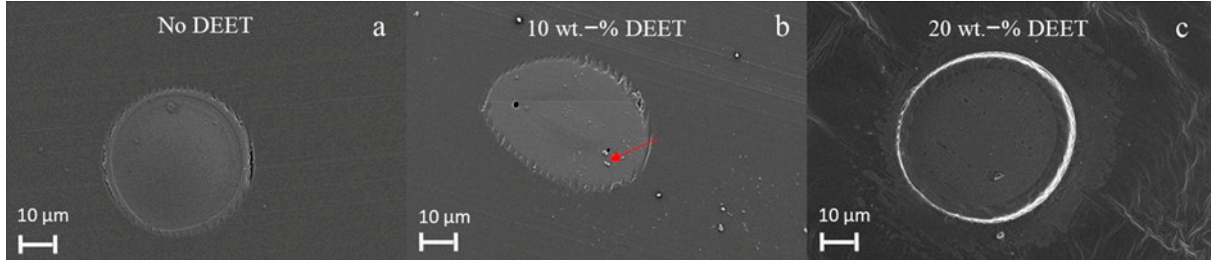
Figure 9. SEM images of PDLLA monofilaments with no DEET ( a ), 10 wt.-% DEET ( b ) and 20 wt.-% DEET ( c ).